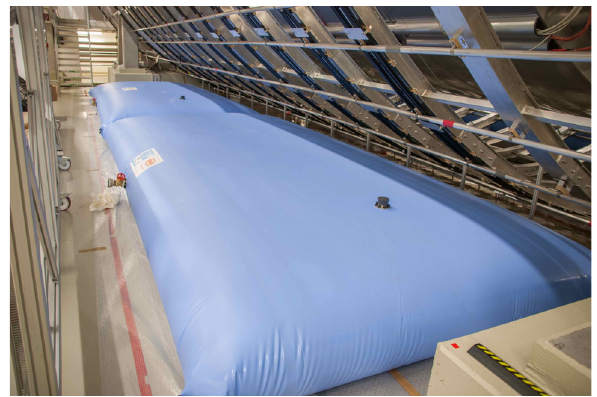
Fig. 8 Two of the four flexible water tanks placed beneath the MS during the gamma suppression measurements